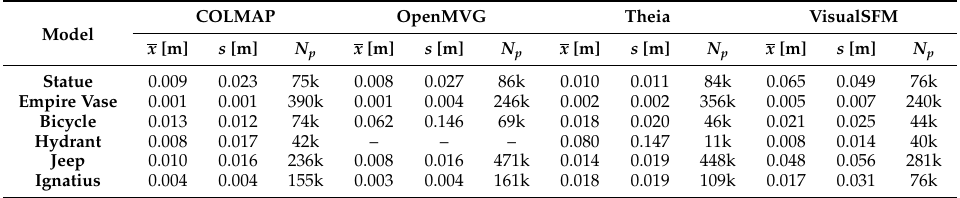
Table 4. MVS cloud evaluation results. x is the average distance of the point cloud from the ground truth and s its standard deviation. N p is the number of reconstructed points.